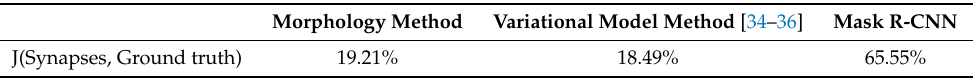
Figure 11. The comparison of synapse segmentation results (Row 1: raw images; Row 2: the ground truth; Row 3: segmentation results of the morphology method; Row 4: segmentation results of the method in [34–36]; Row 5: segmentation results of Mask R-CNN). Table 1. Comparison of synapse segmentation.